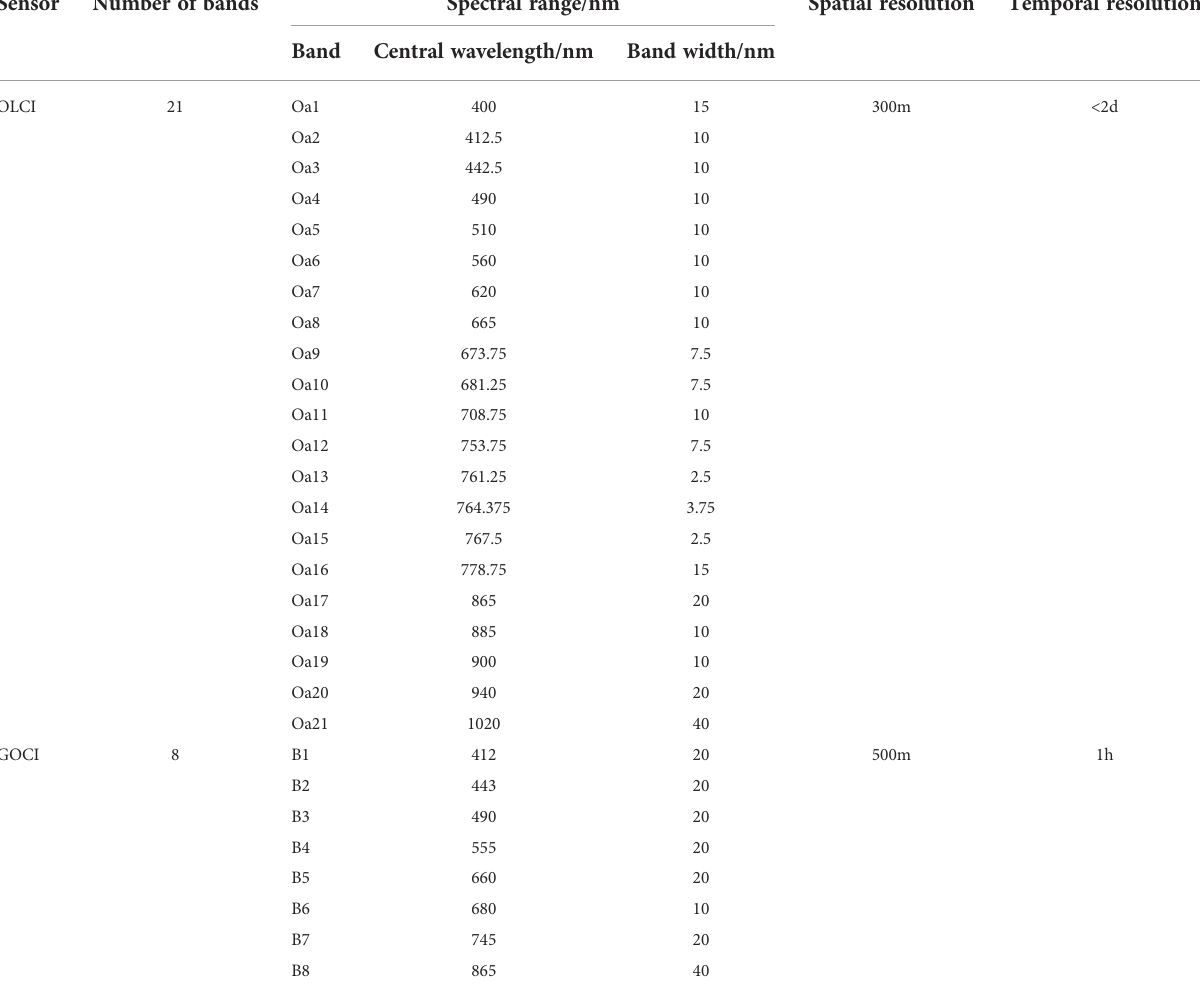
TABLE 1 Basic parameters of OLCI and GOCI